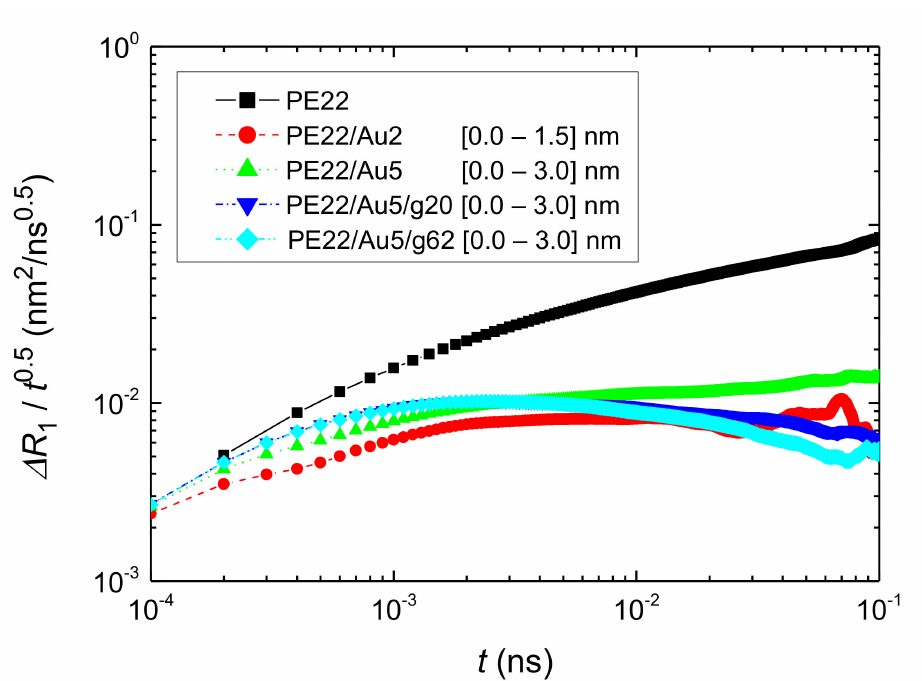
Figure A13. Segmental MSD of PE chains for the first adsorption spherical shell, ∆ R 1 , scaled with t 0.5 . Data for the PE22/Au2, PE22/Au5, PE22/Au5/g20 and PE22/Au5/g62 systems are shown, together with data for the bulk PE22